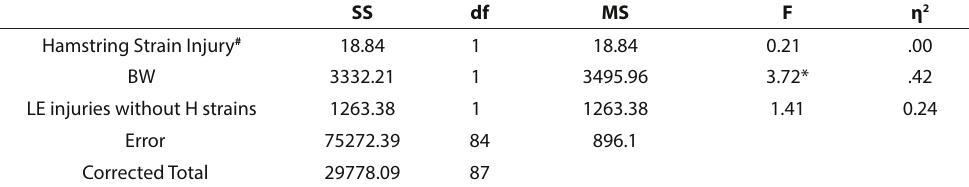
TABLE 4 ANCOVA Results for the eff ects of Hamstring Strain Injury on HSI (BW and other “LE injuries other than H strain injuries” are